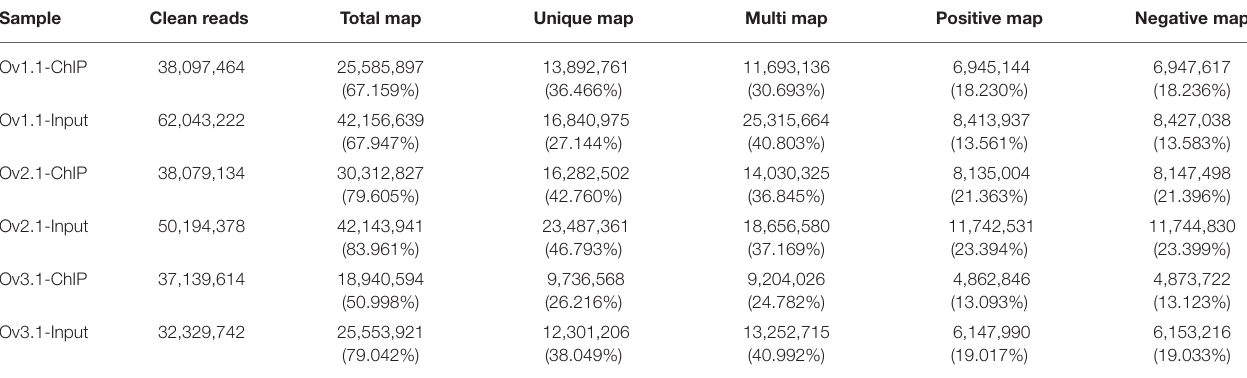
TABLE 2 | Summary of ChIP-Seq reads from six libraries matched to the hazel ( Corylus heterophylla Fisch.) genome.